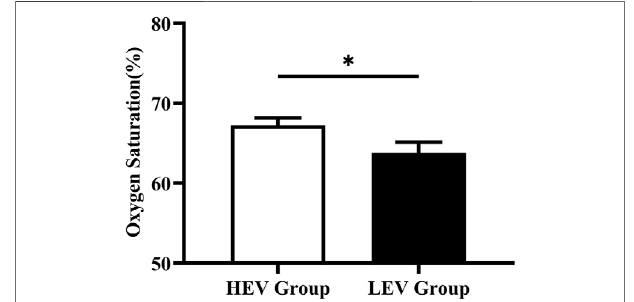
FIGURE 3 | Results of oxygen saturation of plantar tissue in participants (Mean with SEM). HEV: High Exercise Volume ( ≥ 27 Mets · h/week); LEV: Low Exercise Volume ( < 27 Mets · h/week); SEM: standard error of mean. * indicates a signi fi cant difference between the HEV group ( n < 45) and LEV group ( n < 35) ( p < 0.05).